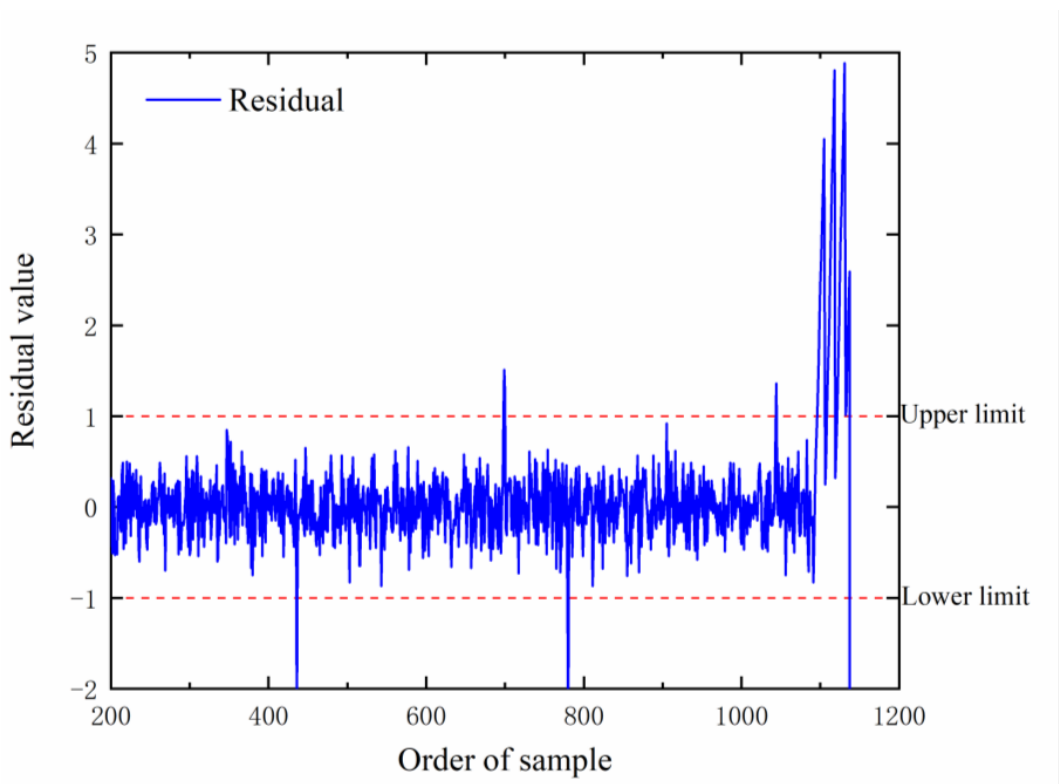
Figure 15. Residual curve plot of abnormal state.